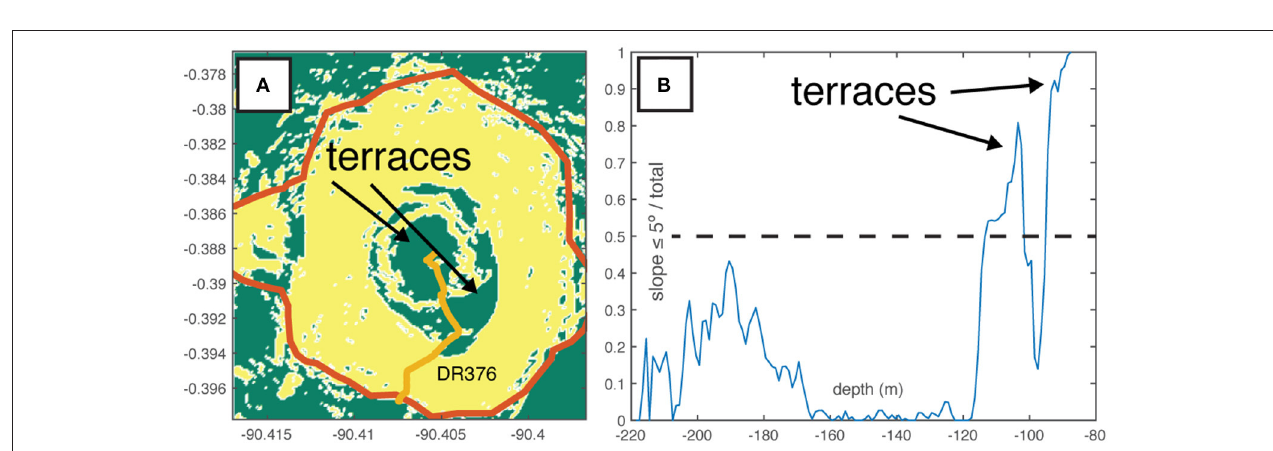
FIGURE 3 | Example of terrace identification. (A) Slope map of a seamount where two terraces have been identified. Areas where slopes are ≤ 5 ◦ (terraces) are shown in green and slopes > 5 ◦ are shown in yellow. Seamount footprint is shown as a thick red line and was manually digitized as the break in slope ≥ 5 ◦ . Gold line shows the dive track for seamount DR376. (B) ratio of pixels with slope ≤ 5 ◦ to all pixels at that depth within the seamount footprint. Peaks in the distribution where ratio is > 50% are identified as